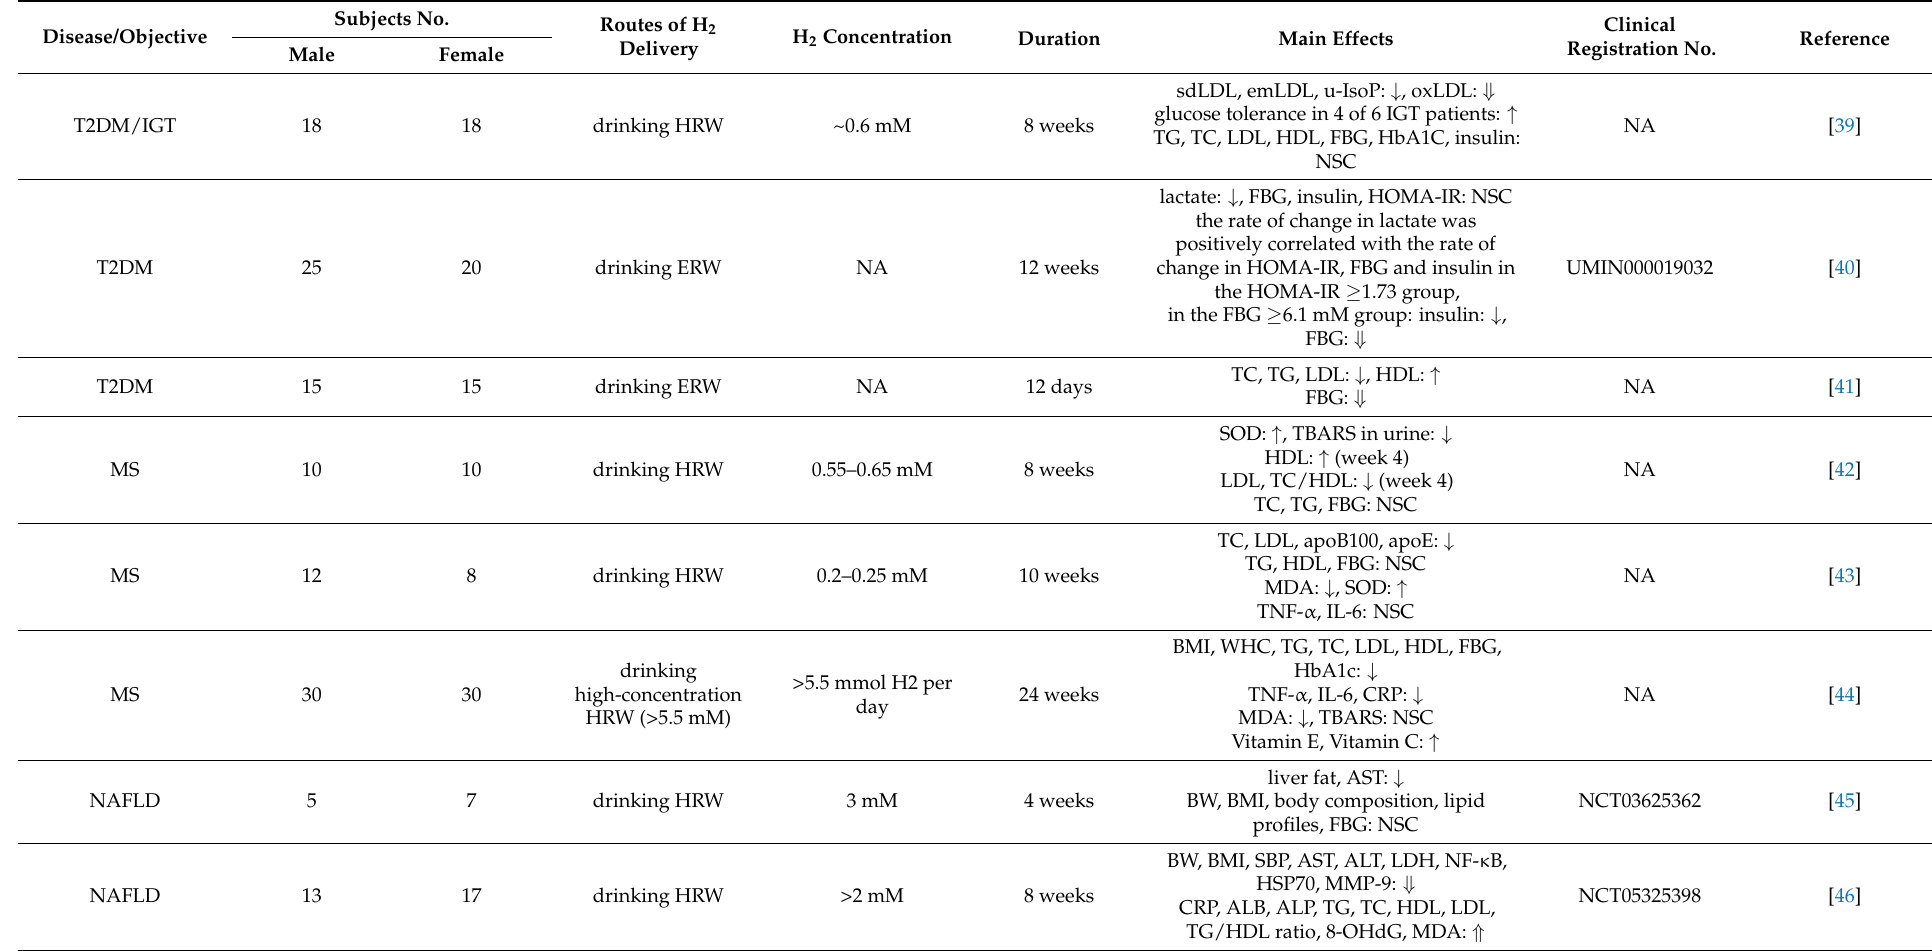
Table 2. The effects of H 2 intervention on metabolic diseases in clinical